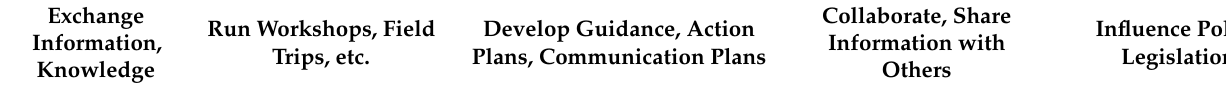
Table 2. Examples of actions undertaken by the networks aiming to improve the management of trees and woodlands facing pests and